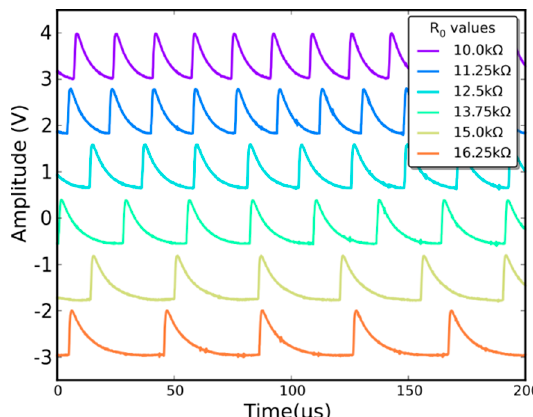
Figure 2. Electrical oscillations induced in the VO 2 -based microbridge under a constant voltage bias (1.7 V) for different values of the electrical resistance in series. The chosen value of R 0 determines the frequency of the electrical oscillations and thus the frequency of the electro-mechanical oscillations. Traces represent the voltage across R 0 and are shifted vertically of 1.2 V for better clarity.